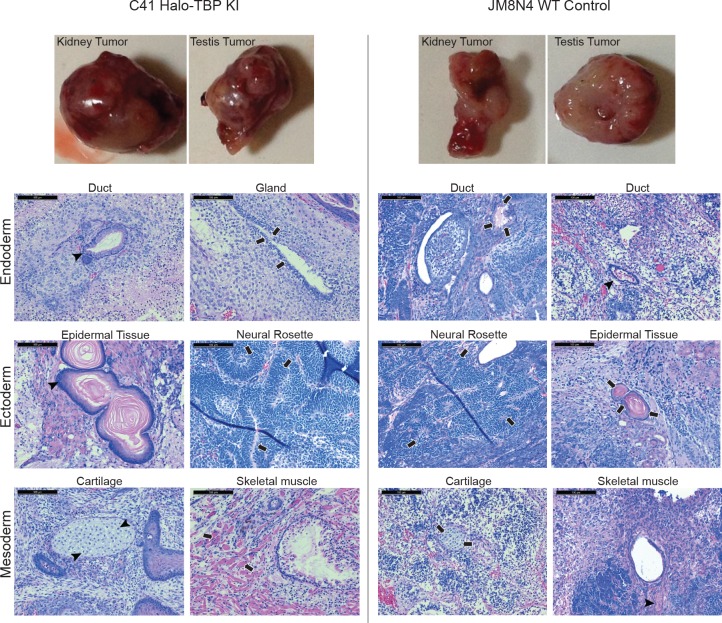
Halo-tagged TBP mouse ES cell line remains pluripotent.The C94 Halo-TBP mES cells (left) or WT JM8.N4 mES cells (right) were injected into SCID-Beige mice. Thirty days post inoculation, kindey and testis tumors were harvested and a sample tumor is shown (top). Histological analyses of tumors show small areas of differentiated cells, representing endoderm, mesoderm, and ectoderm tissues (bottom).